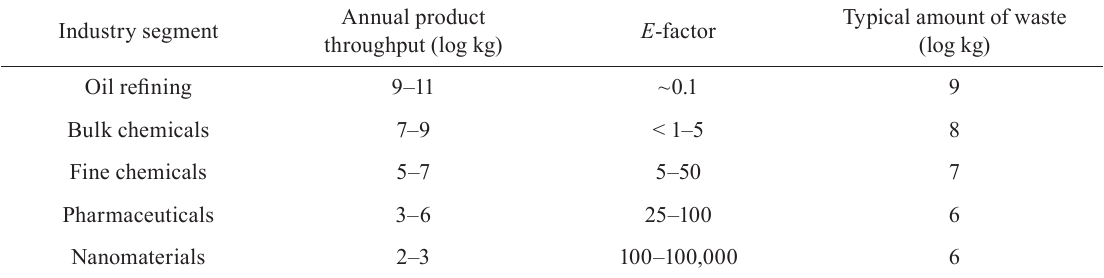
Table 1 Annual product throughput for a typical plant and E -factor comparison for different material classes (based on Sheldon (2007) and Eckelman et al.